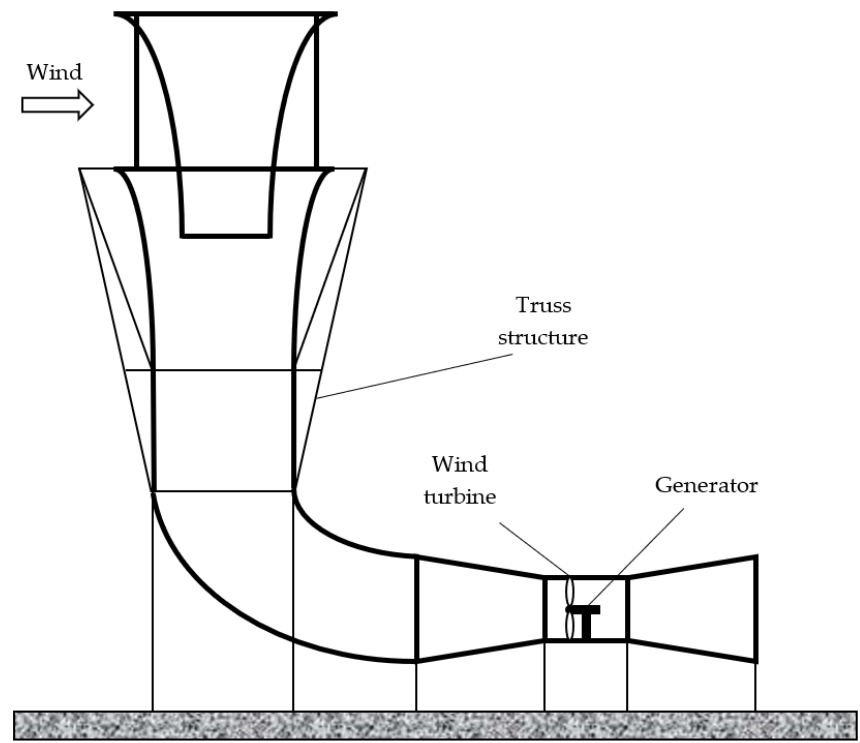
Figure 10. Invelox wind turbine. Adapted from Ref. [96].